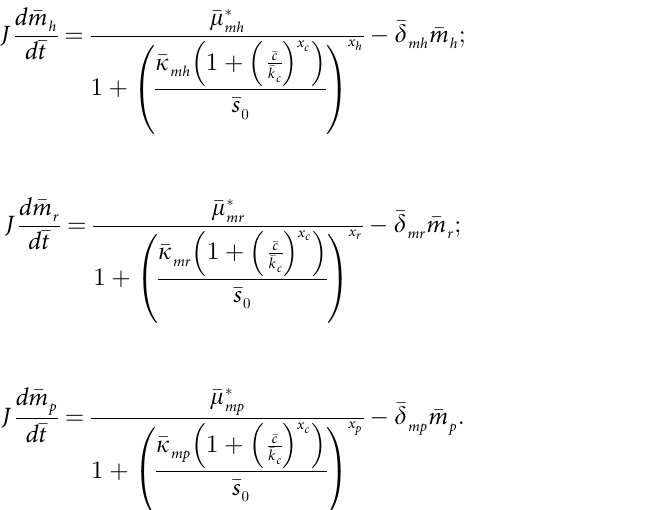
gene binding affinity; x is the number of cholesterol molecules to inactivate SREBP-2; x c correspond to the number of binding sites for SREBP-2 on HMGCR, LDLR and PCSK9 x p genes, respectively; and � d is the rate of mRNA degradation.